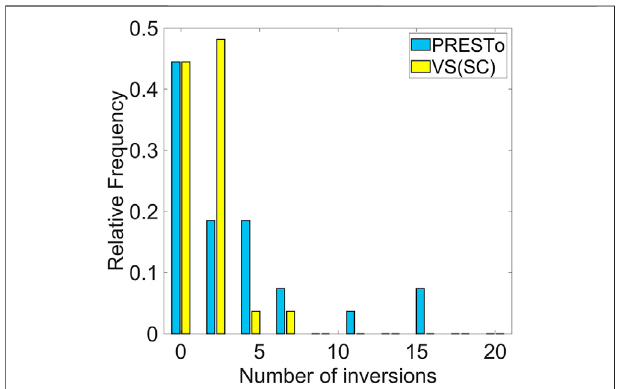
FIGURE 7 | Number of trend inversions in the evolution of PGA estimates for both considered algorithms. The median ( η ), mean ( μ ) and standard deviation ( σ ) of the distributions are: η (cid:2) 2.00, μ (cid:2) 3.37, σ (cid:2) 4.45 for PRESTo, and η (cid:2) 1.00, μ (cid:2) 1.52, σ (cid:2) 1.69 for